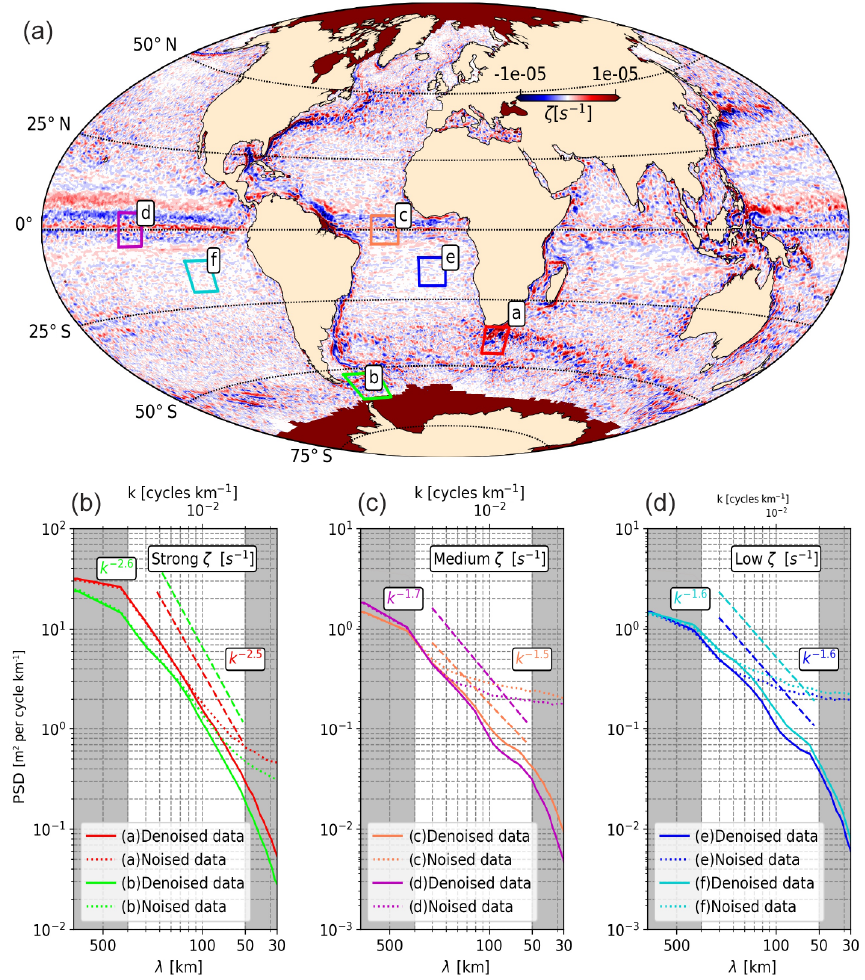
Figure 15. (a) Global map of surface current averaged vorticity (0 . 25 ◦ × 0 . 25 ◦ ) over 2015 from altimeter-derived geostrophic surface currents (Rio et al., 2014). Coloured rectangles are the studied areas through a spectral analysis. (b) The associated 8-year-averaged significant wave height power spectral density (PSD) as a function of wavelength and wavenumber. In solid lines the SWH spectra obtained from denoised SWH data are given, and in dotted lines the spectra for raw data (including estimation noise) are given. Note that, for reading convenience, the y axis is not the same for the three subplots in (b)